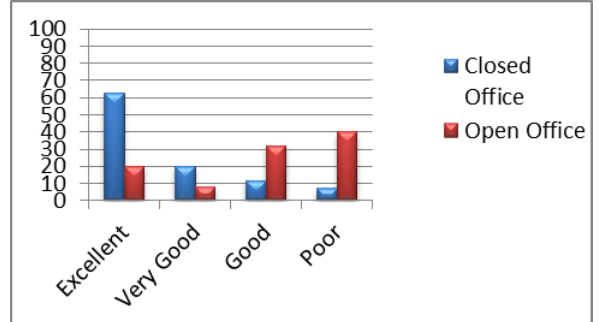
Figure 5 . Acoustical quality of open and closed office. Source: ( Author,